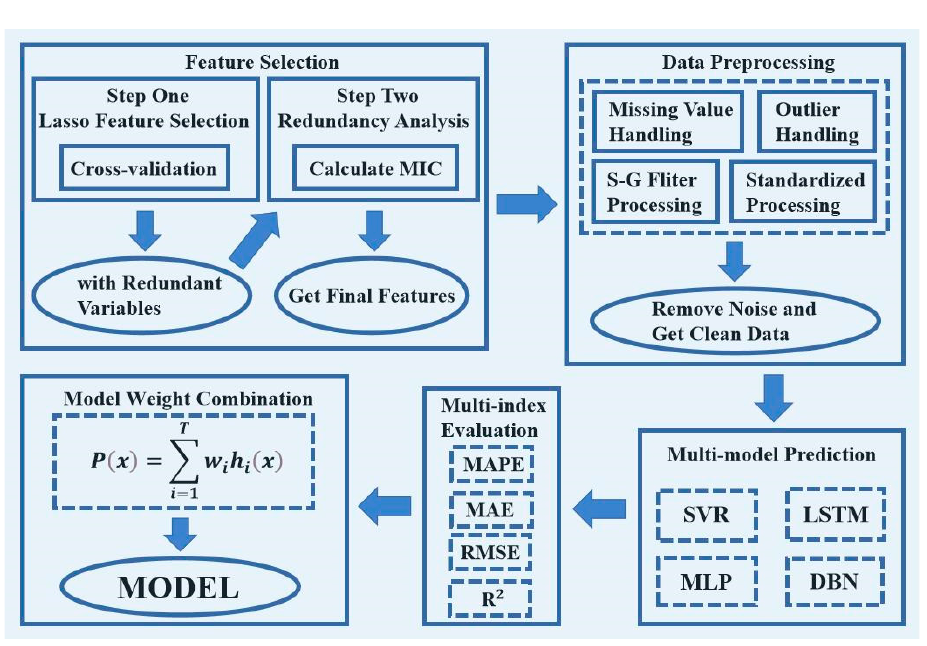
Figure 2. Prediction method of combined multivariate features and models.